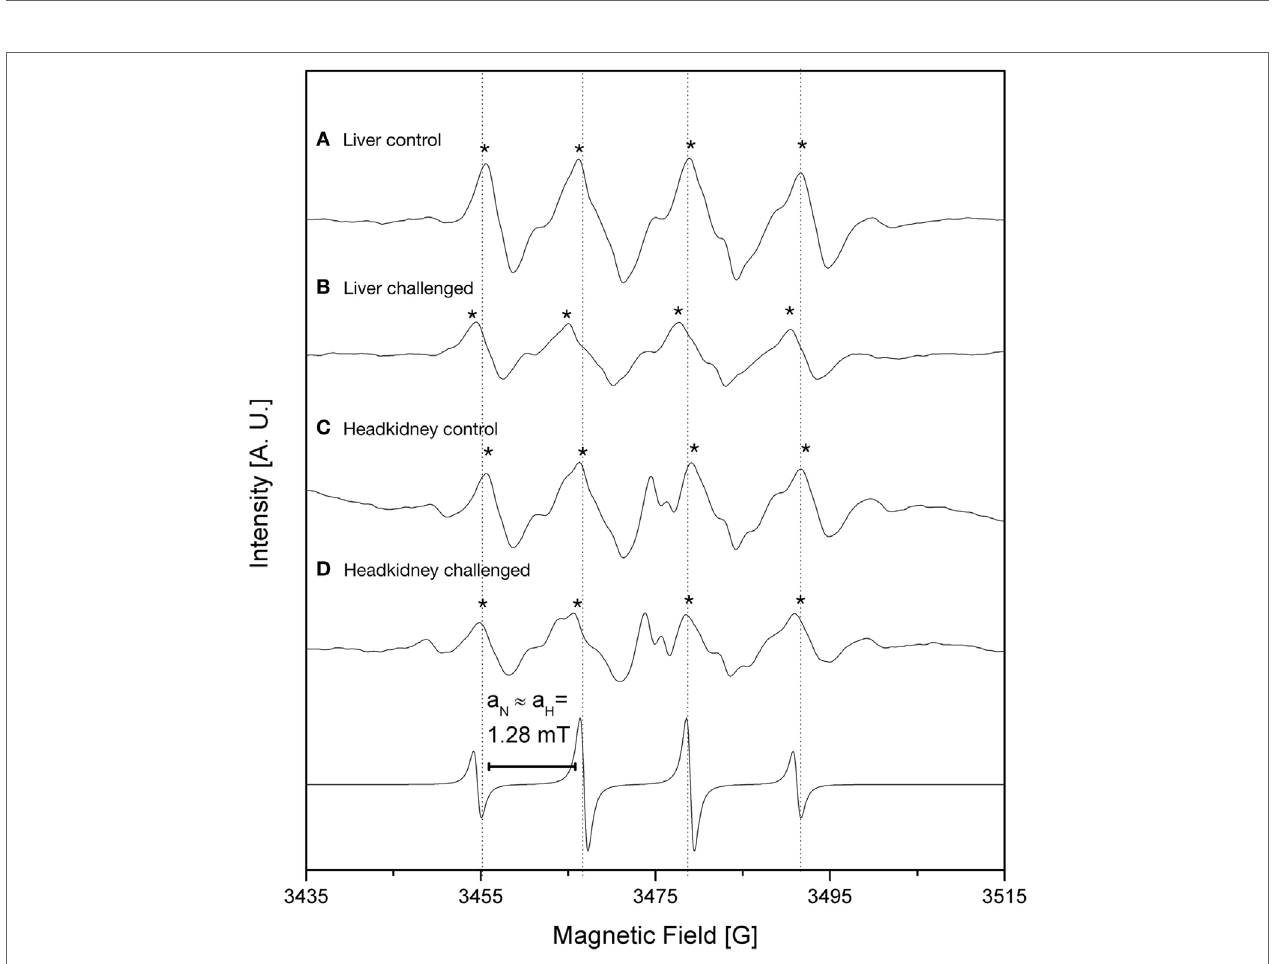
FigUre 2 | Electronic paramagnetic resonance spectra of DMPO spin adducts in fish tissues challenged with infectious pancreaticc necrosis virus (IPNv) virus (53.3 mM, pH 3.6 with 1 N NaOH). (a) liver control, (B) liver IPNv challenged, (c) head kidney control, (D) head kidney IPNv challenged. Upper and lower traces are experimental and simulated spectra, respectively. DMPO/ ⋅ OH spin adducts are denoted